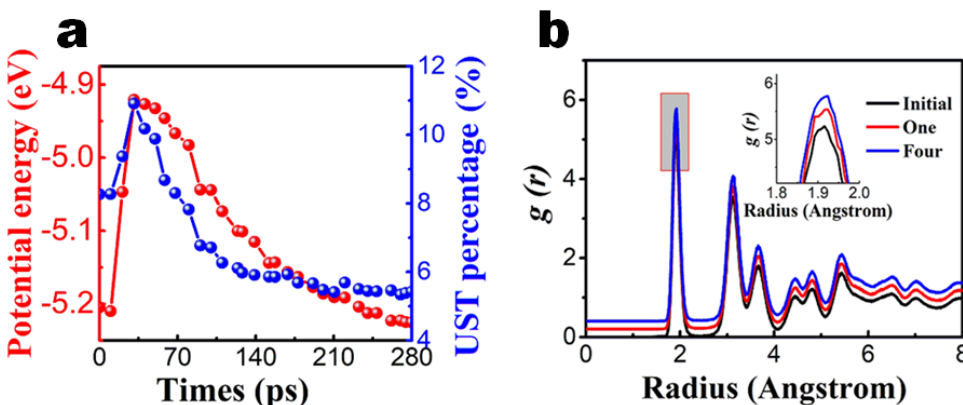
Figure 6. Structure evolution of AlGaN films after laser thermal annealing for Sample B. Sample B contains 154,844 atoms for laser thermal annealing. ( a ) UST atom percentage and average potential energy as a function of annealing time. ( b ) Radial distribution function g(r) of the structures after one and four rounds of annealing compared to that of the initial structure. The RDF curves are shifted 0.2 each for convenience of view. The inset is a zoom-in view of the first peak of RDF to conveniently show the difference.